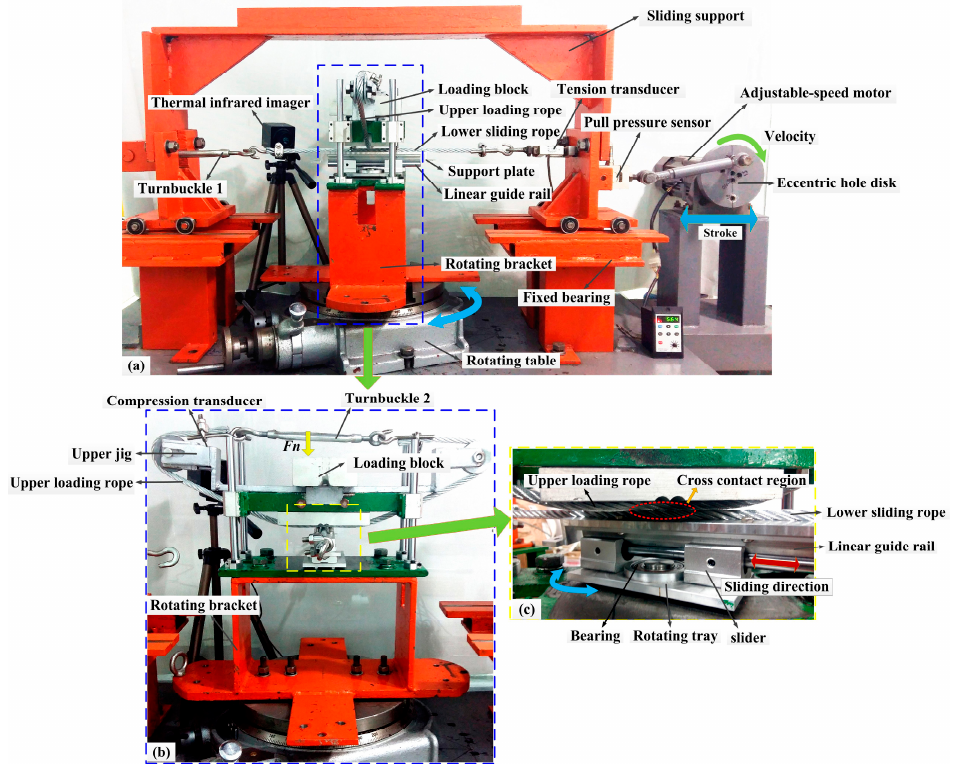
Figure 2. Sliding friction test rig. ( a ) Overall structure of the test rig; ( b ) structure of loading and rotation devices; ( c ) details for the contact condition between the rope specimens.